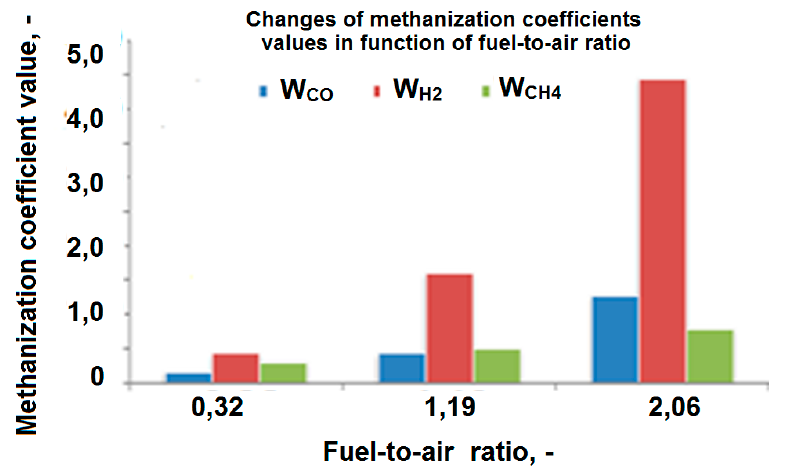
Figure 3. Changes of methanization coefficients values in function of fuel-to-air ratio Φ